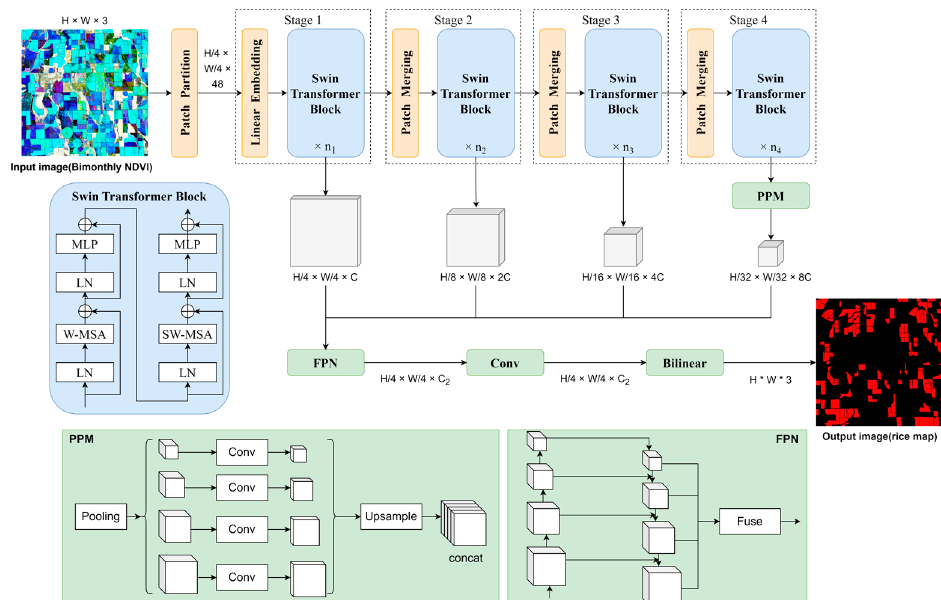
Figure 7. Swin Transformer for rice identification [56].